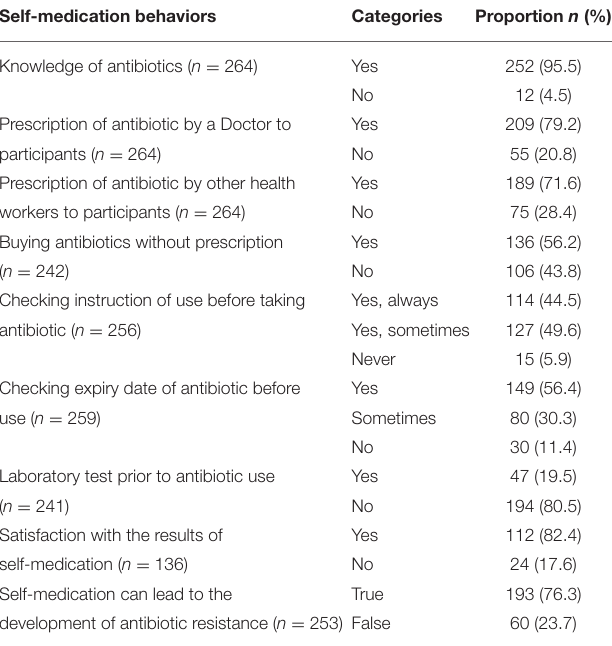
TABLE 2 | Self- medication behavior among participants.